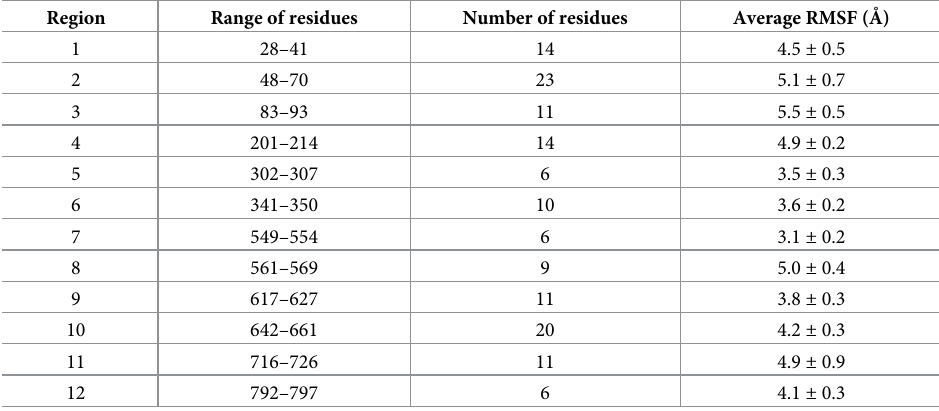
Table 1. Number of residues and average RMSF values of highly flexible regions of the wild-type rhamnosidase. Region Range of residues